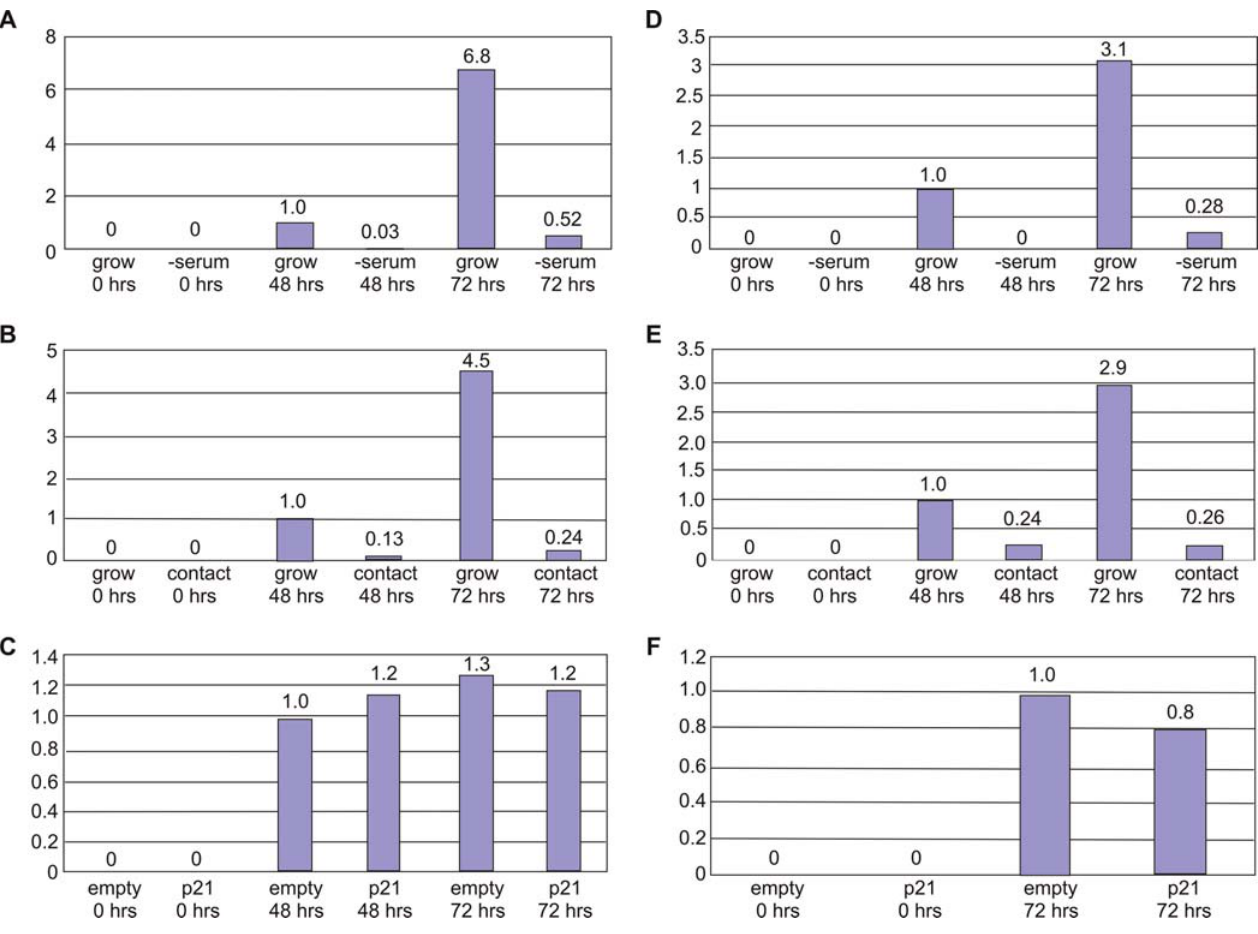
Figure 9. Quiescence, but Not Simply Cell-Cycle Arrest, Protects against Differentiation Human dermal fibroblasts 91-SF5 were transduced with a MyoD-estrogen receptor fusion, selected for stably transduced cells, and differentiated. At the indicated time points after differentiation, myogenin (A–C) and myosin heavy chain (D–F) expression levels were determined with real time RT-PCR using GAPDH as an internal standard and normalized values were plotted. Myogenesis marker expression induced by differentiation was inhibited in cells that were made quiescent for 4 d by serum withdrawal (A and D) or contact inhibition (B and E) as compared with growing cells. In contrast, in cells arrested by overexpression of the CKI p21, there was no reduction in myogenesis marker expression as compared with control cells transduced with an empty vector (C and F). DOI: